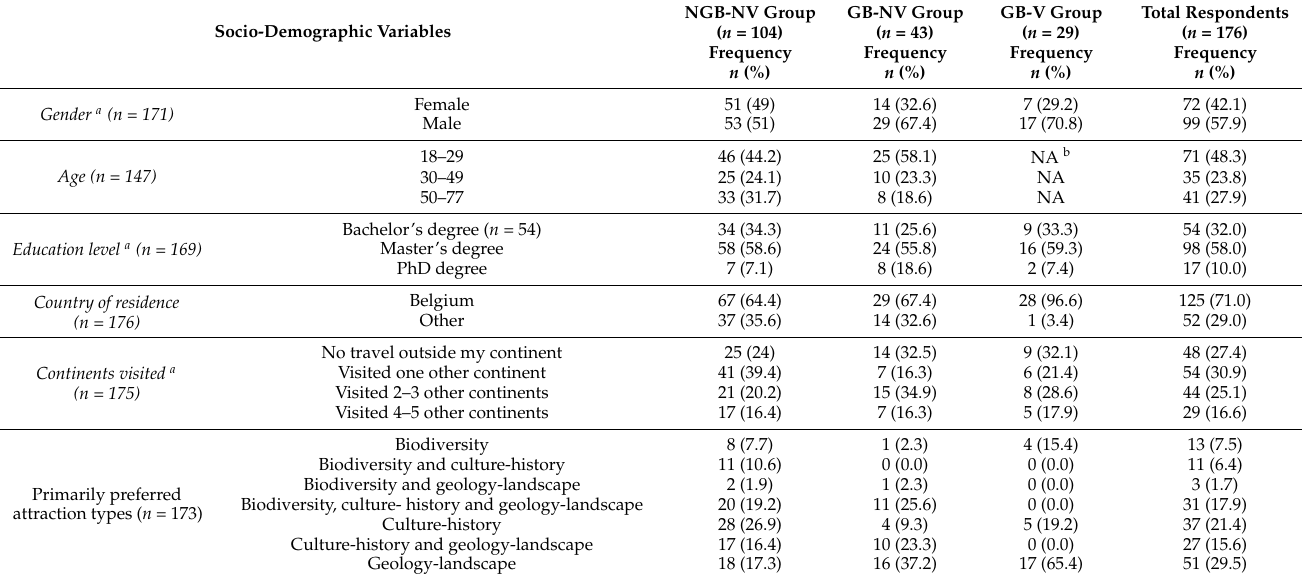
Table A3. Socio-demographic profile of the three respondent groups ( n = number of persons).